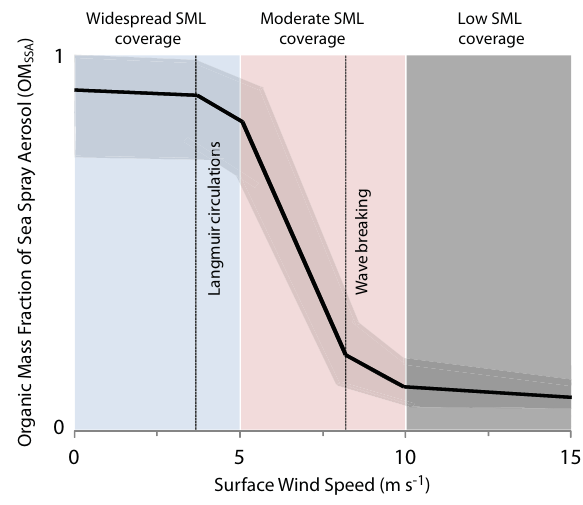
Fig. 1. Conceptual relationship between the organic mass fraction of sea spray aerosol (OM SSA ) and surface wind speed. Different colors depict potential regimes of the physical and chemical char- acteristics of the sea surface microlayer (SML) and the gray shading representing uncertainty in the OM SSA due other environment fac- tors other than wind speed. These values represent global averages and may not be applicable for any given